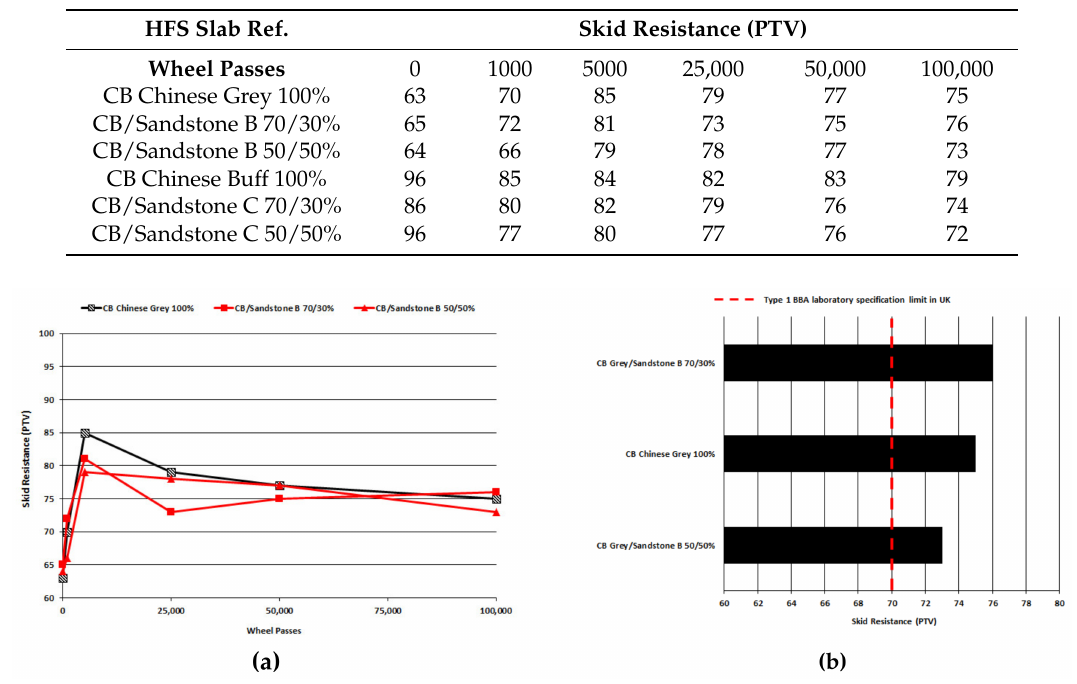
Figure 6. ( a ) Skid resistance development up to 100,000 wheel-passes; ( b ) Skid resistance ranking after 100,000 wheel-passes (Ulster University